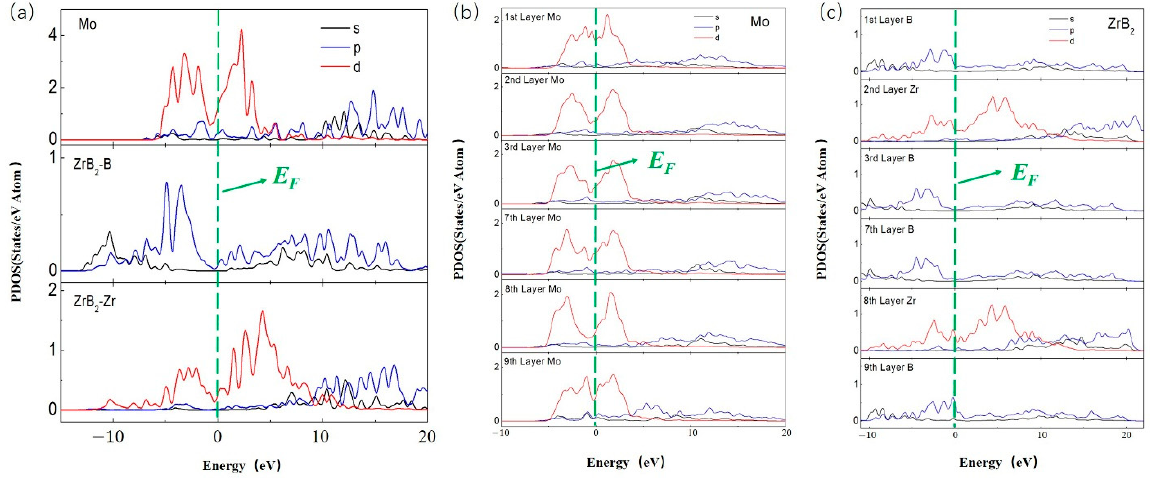
Figure 10. DOS (density of state) projected on the most stable interface after relaxation. ( a ) The partial density of states (PDOS) for bulk Mo and ZrB 2 ; ( b ) the PDOS of the Mo layers; and ( c ) the PDOS of the ZrB 2 layers. The E F is set to zero, denoted by a dash line.